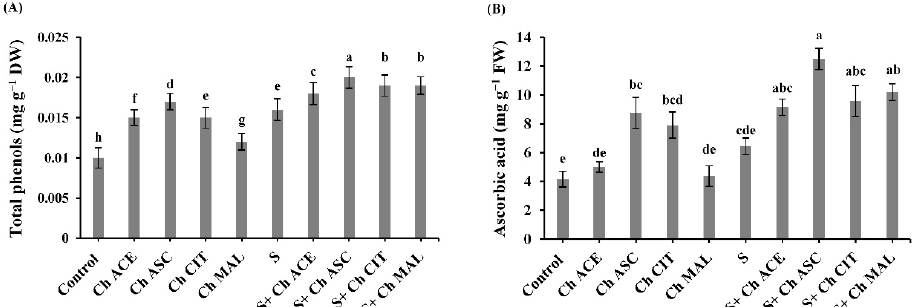
Figure 4. Effect of salinity (S) and foliar application of chitosan dissolved in different organic acids (Ch ACE, Ch ASC, Ch CIT and Ch MAL) and their interactions on the content of ( A ) Total phenols and ( B ) Ascorbic acid of tomato plants. Data are presented as means ± SE (n = 3). Data followed by different letters are significantly different following Tukey’s honestly significant difference (HSD) test at p ≤ 0.05. FW: fresh weight, DW: dry weight.